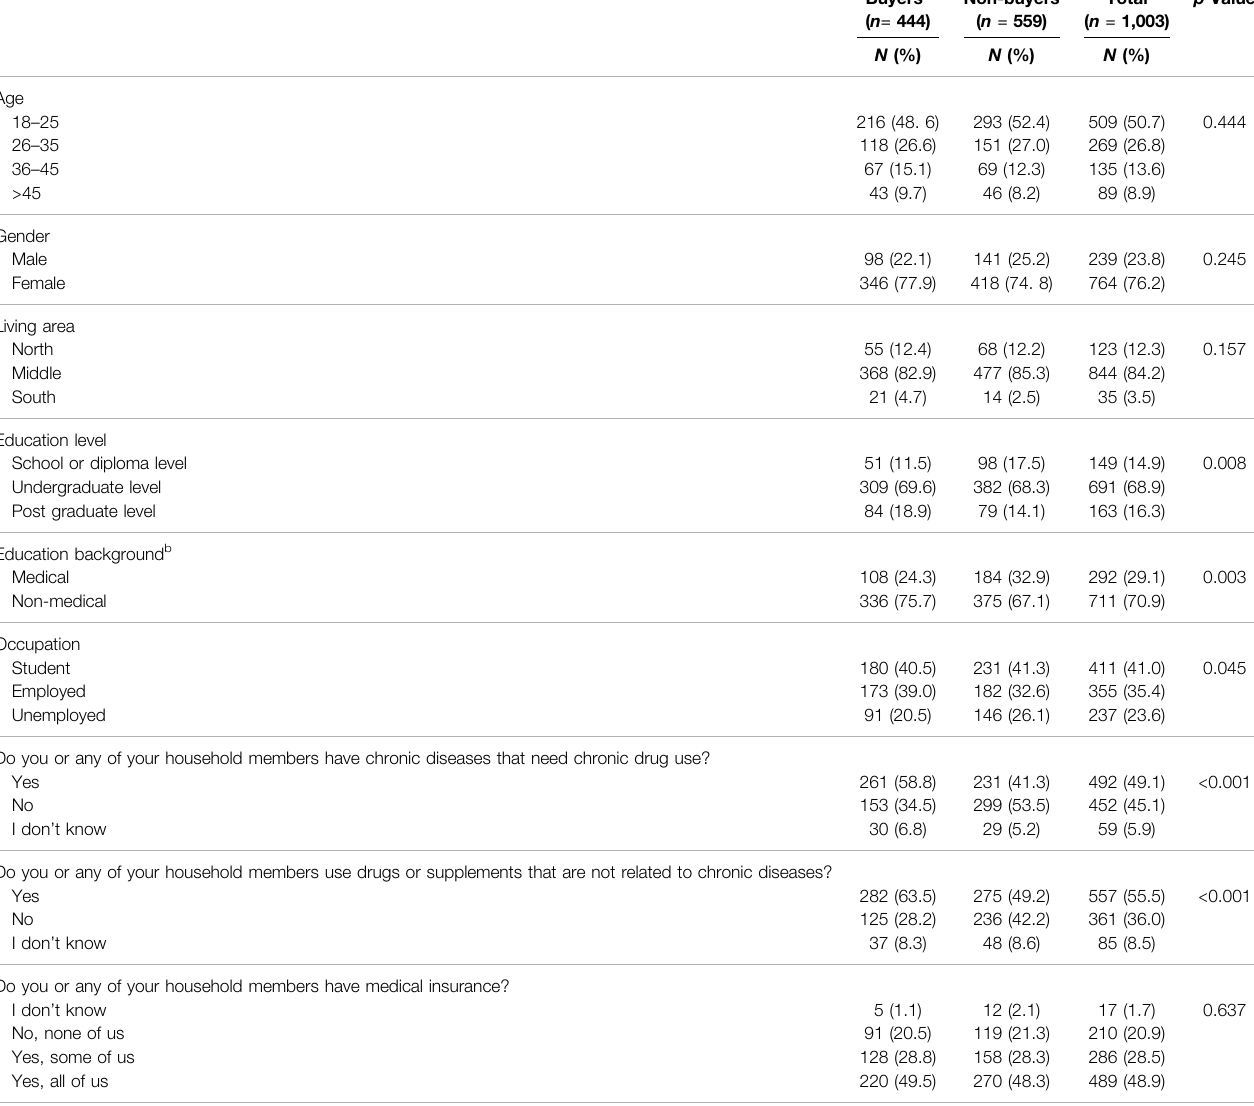
TABLE 1 | General characteristics of the